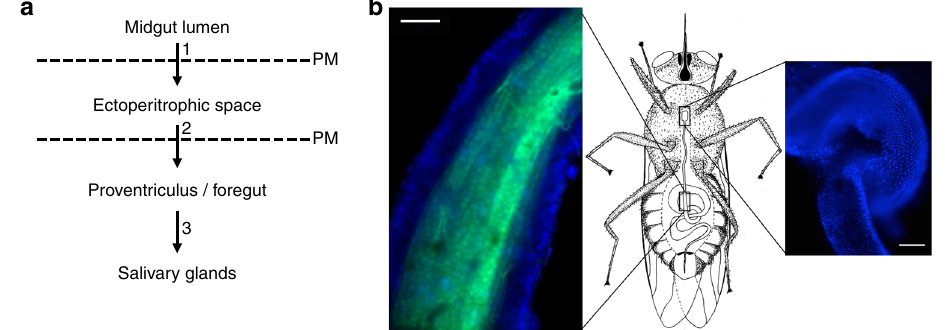
Fig. 1 Course of migration by trypanosomes and anatomical context in the tsetse fl y. a Schematic depiction of the path taken by trypanosomes during cyclic transmission, with numbers 1 – 3 marking major tissue transitions. PM: peritrophic matrix. b Schematic of a tsetse fl y (central panel), with boxed regions indicating the location of the midgut (left panel) and proventriculus (right panel). Left panel, an isolated tsetse fl y midgut in which the nuclei of epithelial cells are stained with Hoechst dye (blue) and the PM is stained with fl uorescein-tagged wheat germ agglutinin (green). Right panel, an isolated tsetse fl y proventriculus stained with Hoechst dye (blue) to visualize nuclei. Scale bar: 100